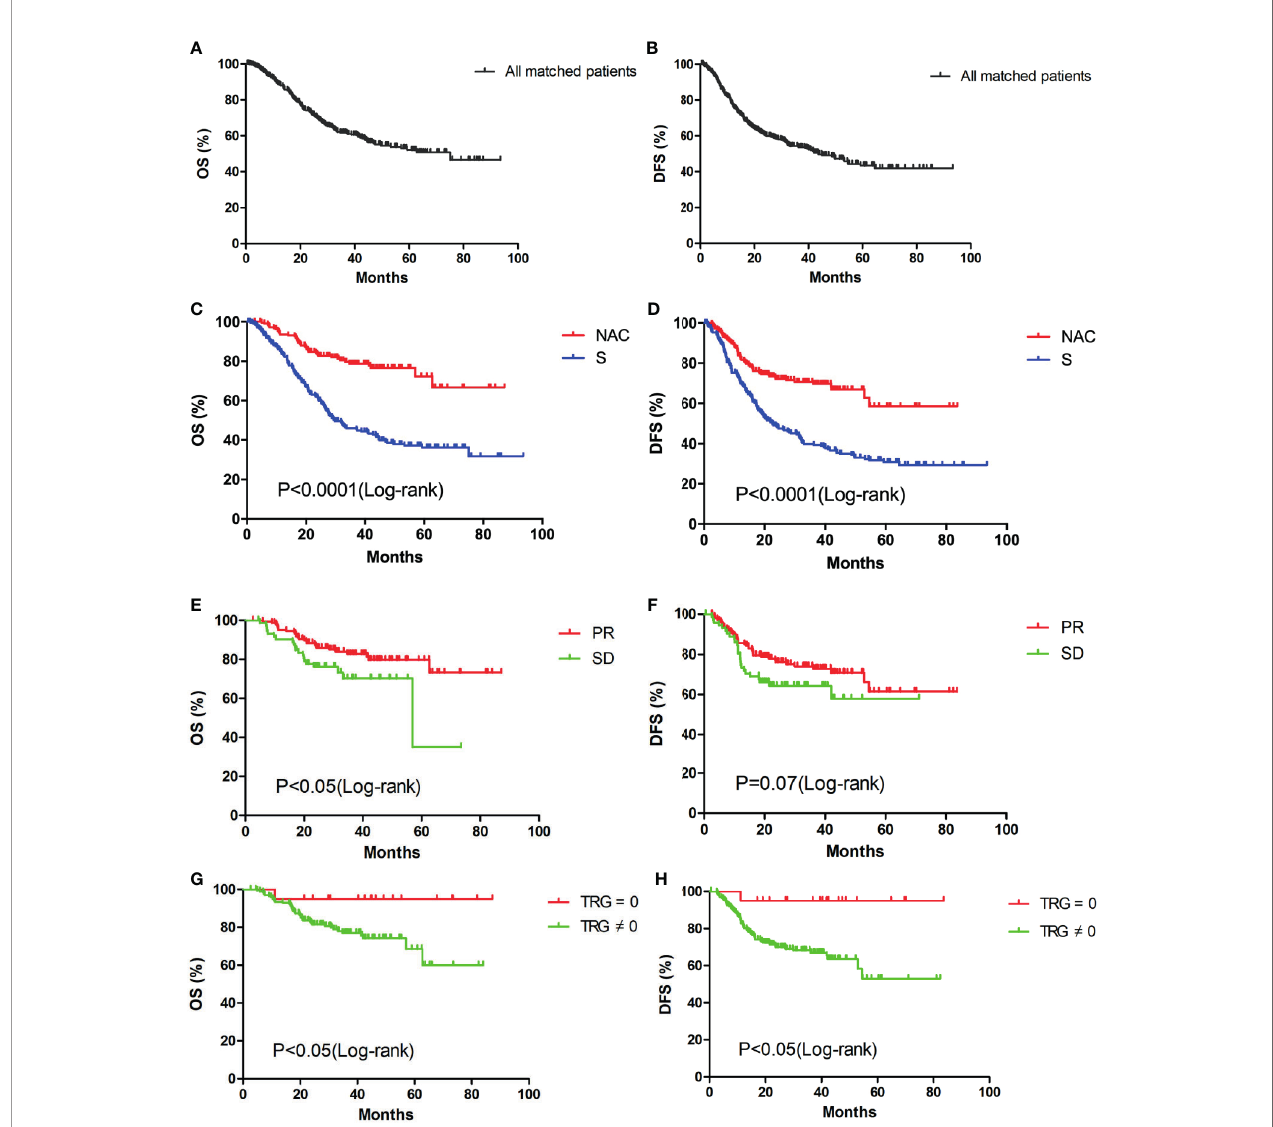
FIGURE 2 | Kaplan-Meier survival curves of overall survival and disease-free survival: OS (A) and DFS (B) analysis of all matched patients (n=442); OS (C) and DFS (D) analysis of patients in the NAC (n=221) and S (n=221) groups; OS (E) and DFS (F) analysis of patients in the PR (n=148) and SD (n=73) groups; OS (G) and DFS (H) analysis of patients in the TRG = 0 (n=20) and TRG ≠ 0 (n=201)